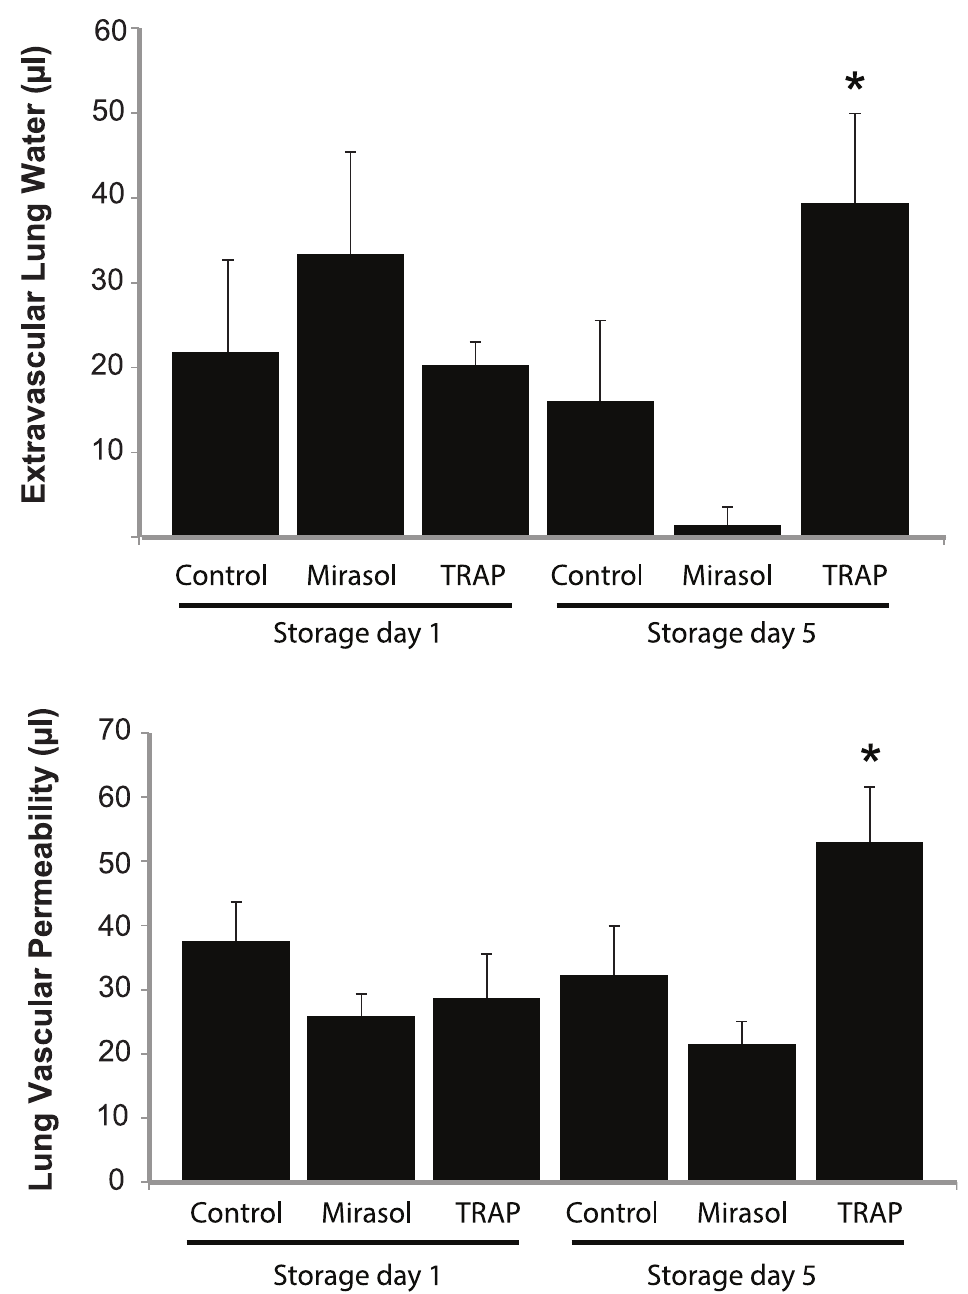
Fig 3. Lung injury in control, Mirasol PRT, and TRAP-treated human platelets transfused into NOD/SCID mice. A. Extravascular lung water in NOD/ SCID mice transfused with 10 9 human platelets (control vs. Mirasol PRT vs. TRAP-activated) on day 1 or day 5 of storage. B. Lung vascular permeability to 125 I-albumin (i.v.) in NOD/SCID mice transfused with 10 9 human platelets (control vs. Mirasol PRT vs. TRAP-activated) on day 1 or day 5 of storage. * p < 0.05 vs. day 5 control and Mirasol PRT groups. TRAP = thrombin receptor activating peptide (50 μ M). Mean ± SD. n = 5 per